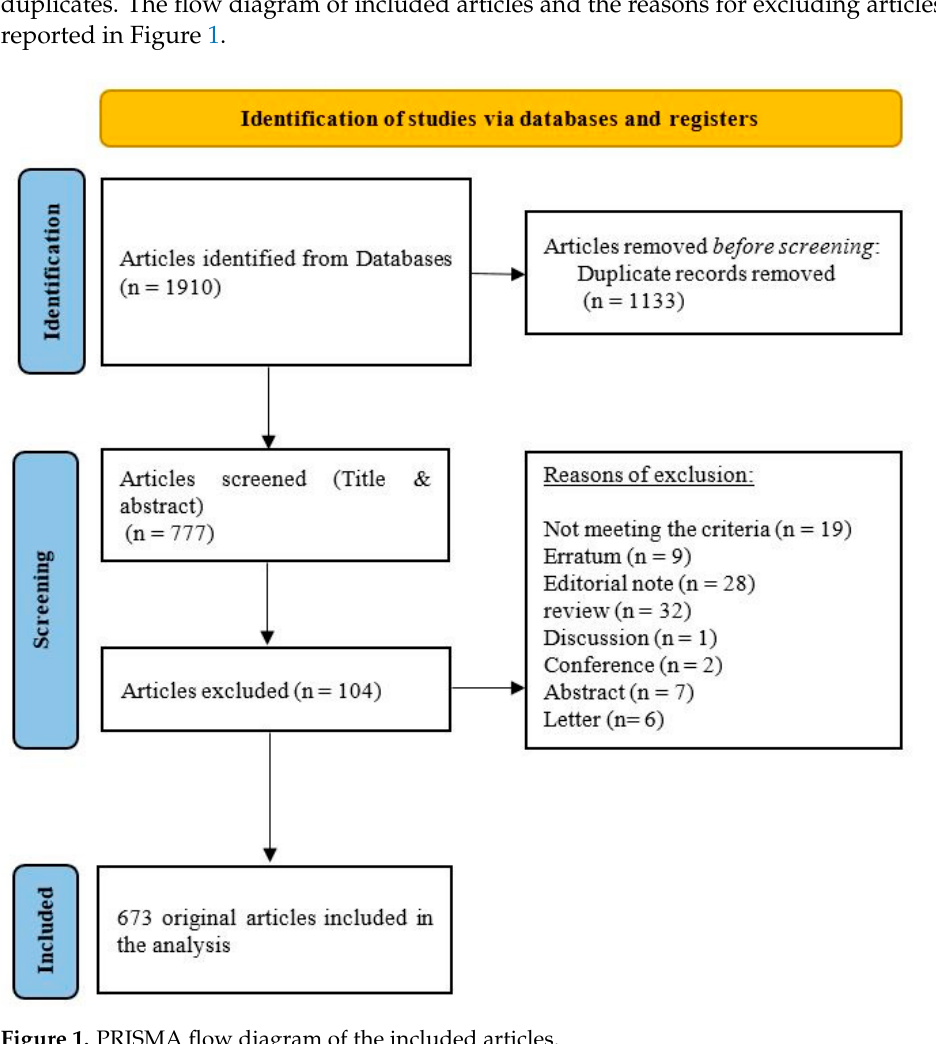
Figure 1. PRISMA flow diagram of the included articles.